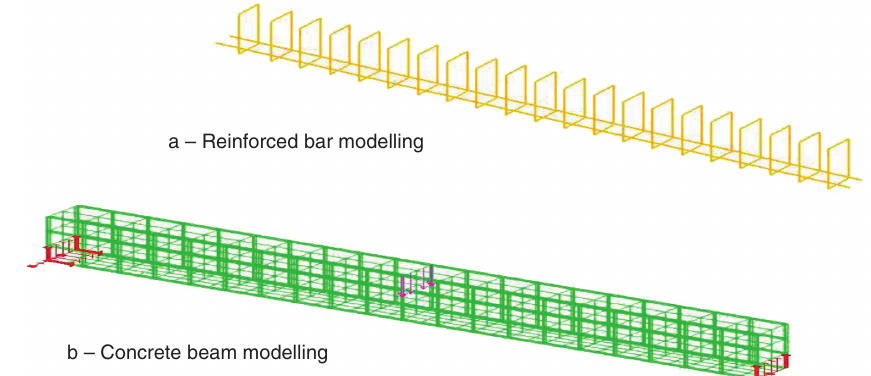
Fig. 4. Finite element model of reinforced concrete